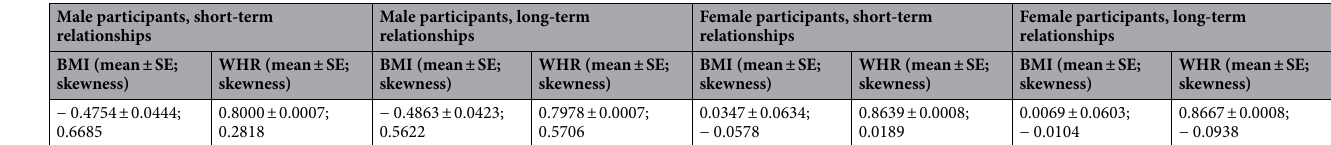
Table 1. The mean value of BMI and WHR for short-term relationships and long-term relationships.